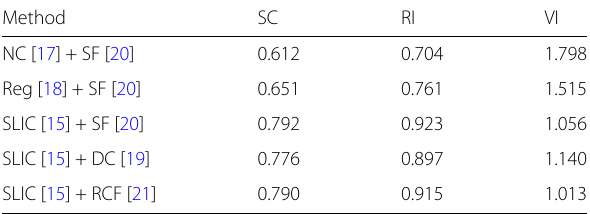
Table 1 Comparison of segmentation results